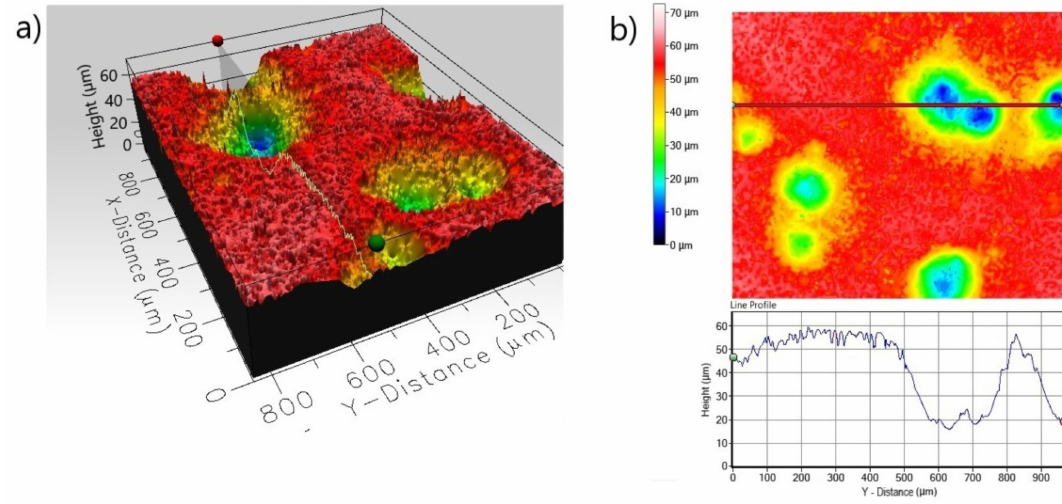
Figure 14. 3D profile ( a ) and 2D profile ( b ) of the corroded surface of non-borided Nimonic ® 80A alloy after the corrosion resistance test in a 3.5% NaCl solution.